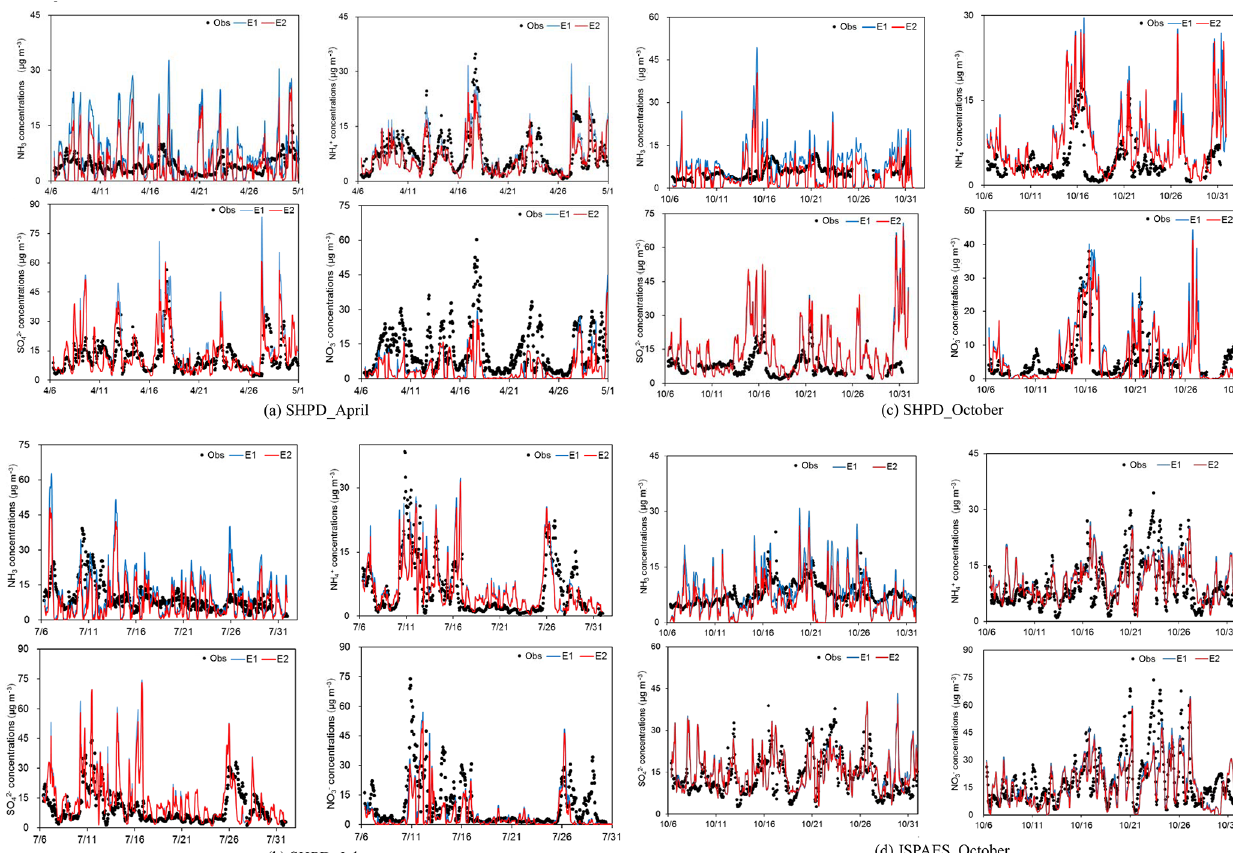
Figure 8. The observed and simulated hourly NH 3 and SIA concentrations with the two inventories at the JSPAES and SHPD sites.